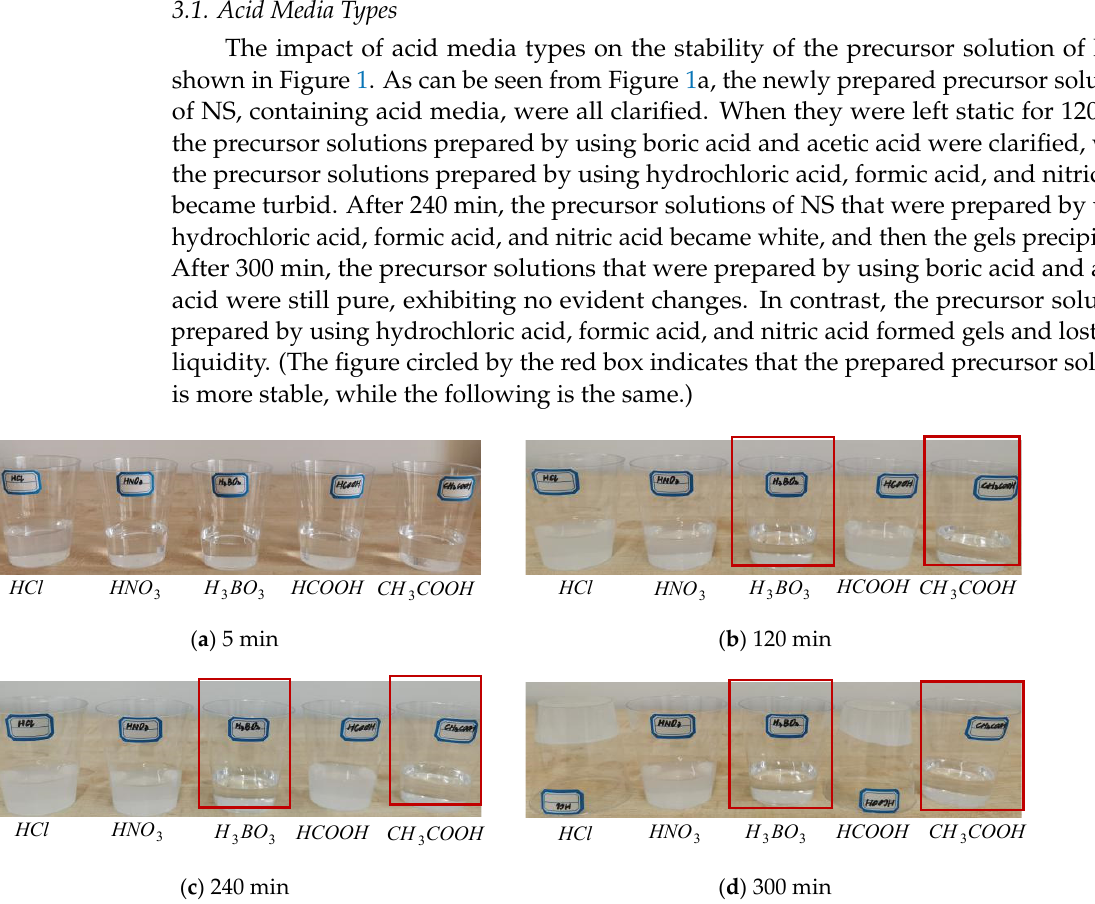
Figure 1. The effects of acid media types on the stability of precursor solutions of NS.